Question: In a single sentence, describe what this figure presents.
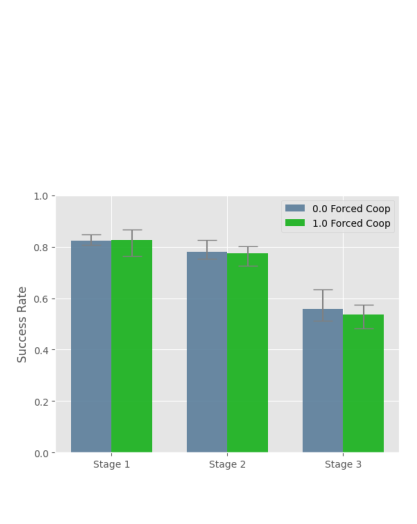
Answer: Evaluation for agents trained on 0% vs 100% forced cooperation tasks